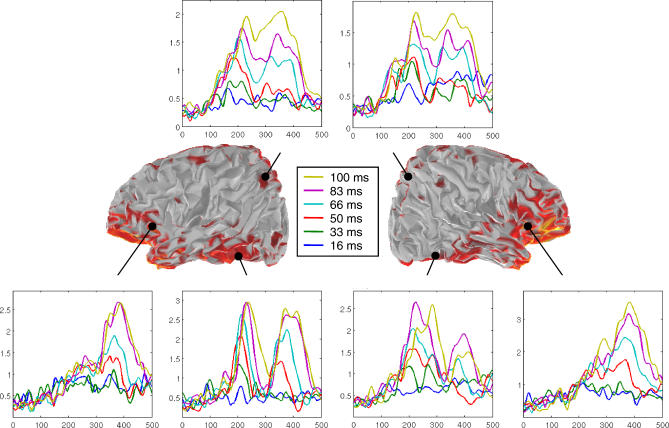
Sequence of Cortical Activity Evoked by the Masked TargetsLeft and right views of the partially inflated hemispheres show the reconstructed cortical sources at the peak of the P3 (370 ms) in the condition of maximal visibility (SOA = 100 ms). Colors indicate the activation of reconstructed cortical sources, expressed in current density units (A.m), thresholded at 50% of the maximum (yellow = 10−−7 A.m). Insets show the profiles of mask-subtracted activity (average of absolute current density) in six bilateral regions of interest (right and left posterior parietal, posterior ventral temporal, and inferior frontal areas), separately for the six conditions of SOA. Two phases of cortical activation can be distinguished. In a first phase, prior to about 300 ms, activation progresses from the occipital pole toward both parietal and ventral temporal sites, and its amplitude increases roughly linearly with target-mask SOA. In a second phase, after 300 ms, there is a sudden onset of high-amplitude activity, with a sigmoidal profile, particularly in ventral prefrontal cortex, accompanied by a concomitant reactivation of all previous posterior sites.